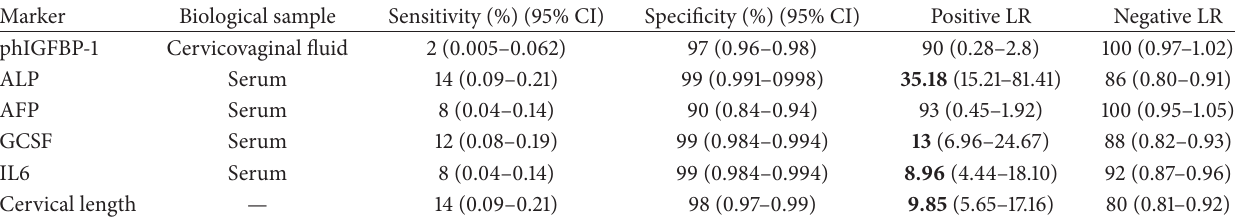
Table 4: Showing sensitivity, specificity, and positive and negative likelihood ratios (LR) of some